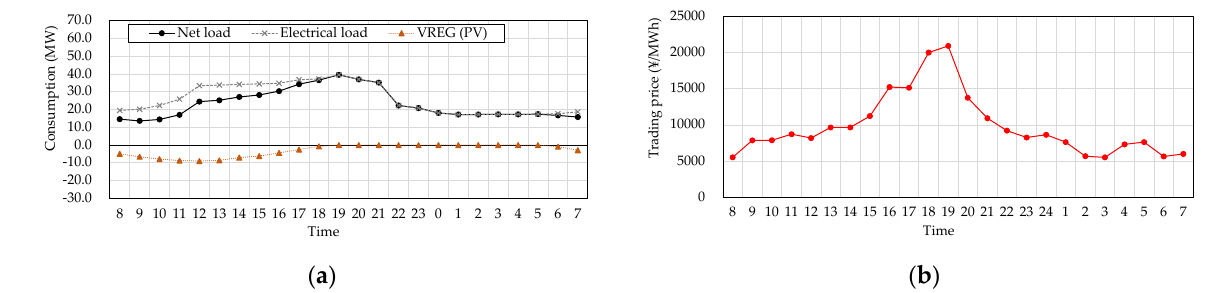
Figure 4. Profiles of net load and trading price: ( a ) Net load profile; ( b ) Price profile (“¥” means “any currency unit is applicable”).